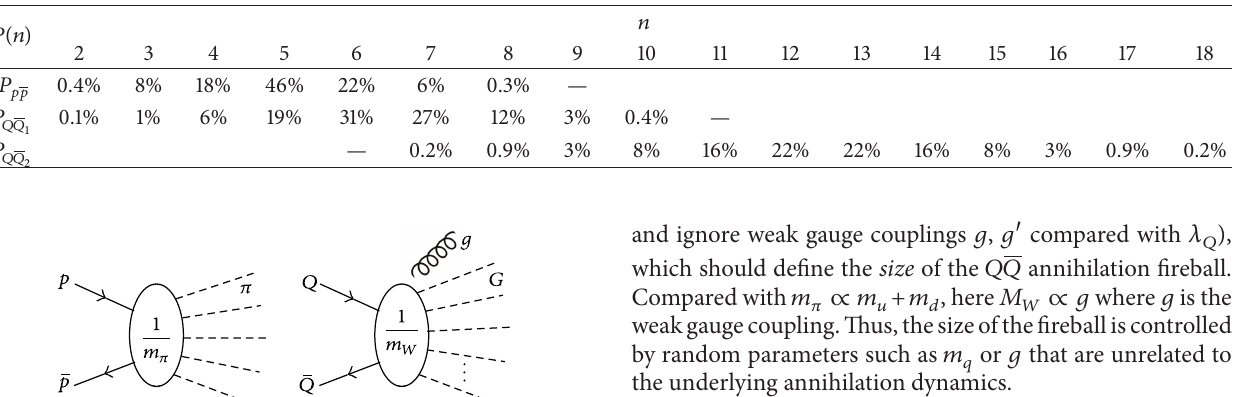
Table 1: Sample multiplicity distributions: 𝑃 𝑝𝑝 (𝑛) is the observed distribution for 𝑝𝑝 → 𝑛𝜋 [51], while 𝑃 𝑄𝑄 distribution for 𝑚 𝑄 = 1 (2) TeV according to (58), where 𝐺 ≡ 𝑉 𝐿 is the electroweak Goldstone boson.